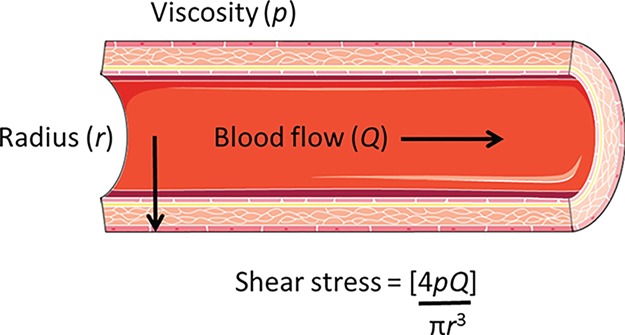

 Cross-sectional diagram of a vessel showing SS produced by blood flow. SS in force/unit area (dyne/cm2) can be calculated using the equation SS = (4pQ)/πr3, where r is the vessel radius (μm), Q is blood flow velocity (μL/s), and p is blood viscosity in poise (dyne.s/cm3). 10 dyne/cm2 = 1 Pascal. Adapted from Malek et al., 1999, Wareing, 2012.